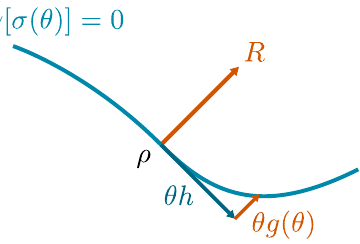
FIG. 6. Each R is a vector normal to the surface defined by γ ½ ρ ð g Þ(cid:2) ¼ 0 in density-operator space. For any h ∈ R ⊥ , a para- metric submodel σ ð θ Þ can be constructed to satisfy the constraint γ ½ σ ð θ Þ(cid:2) ¼ 0 . Away from ρ , a correction θ g ð θ Þ ¼ o ð θ Þ in R is needed to make σ ð θ Þ stay with the constraint. The tangent vector of the submodel at ρ is still h , since the correction is higher order in θ